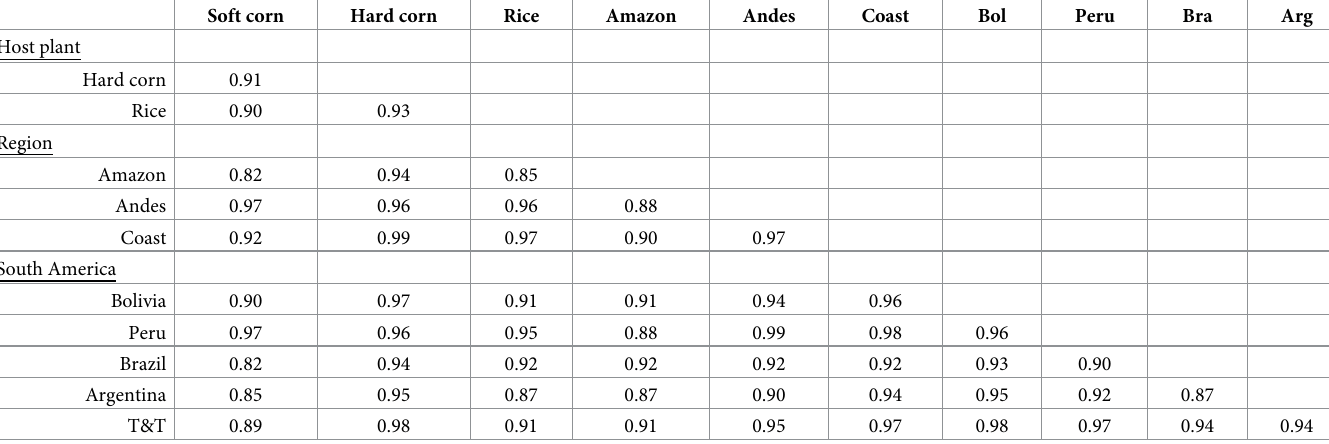
Table 2. Comparison of TpiI4 haplotype profiles from the different host plants and locations (described in Fig 3) as analyzed by Pearson ( r ) correlation tests. Num- bers represent Pearson r values. All pairwise comparisons showed a statistically significant positive correlation ( P < 0.01). Abbreviated countries: Bolivia (Bol), Trinidad- Tobago (T&T), Brazil (Bra), and Argentina